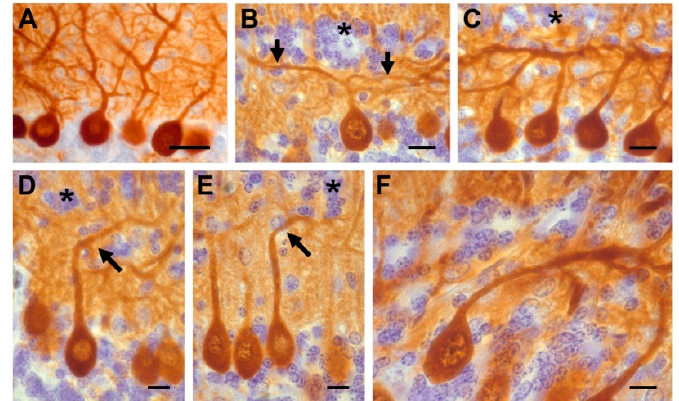
Figure 3. ( A ) Calbindin-reactive Purkinje cells in saline rats whose dendrites grew in the normal, upward direction. ( B – F ) Hydroxyurea-treated cerebella showing different patterns of dendritic arborization. Asterisks show ectopic interneurons and black arrows indicate the altered dendritic tree. Scale bar: 30 µm (A); 10 µm (B–F).